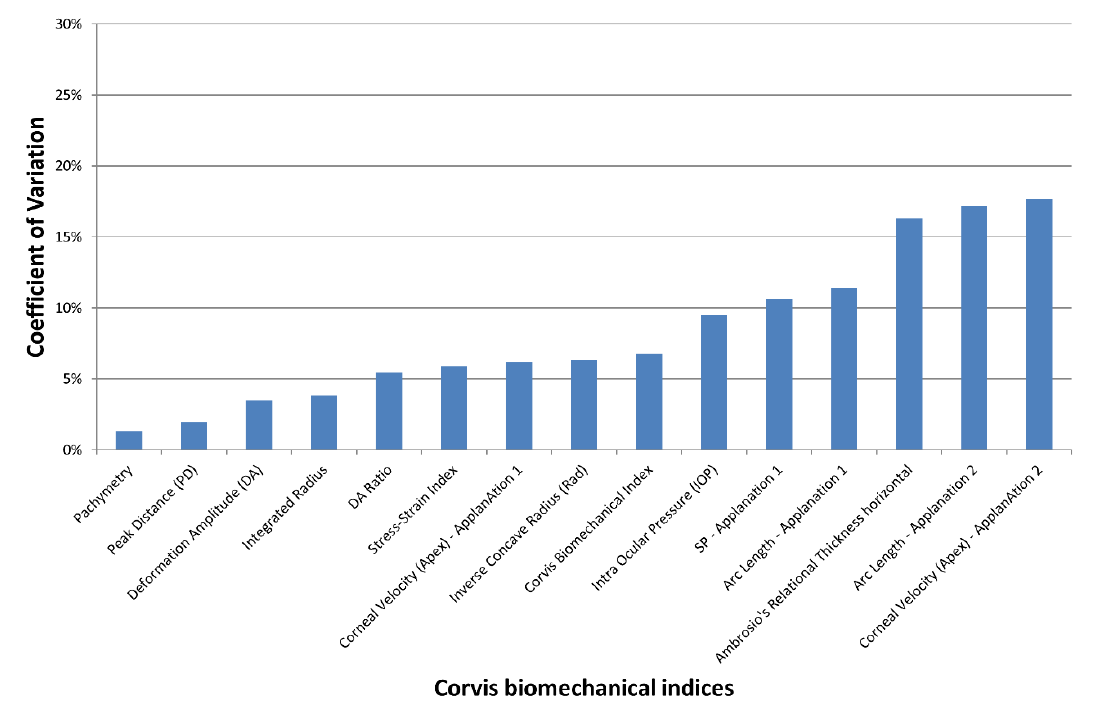
Figure 2. Mean coefficient of variation (COV) of the Corvis ST indices obtained by 3 different orthoptists in the keratoconus group. The inter-observer reproducibility decreases with increased COV.